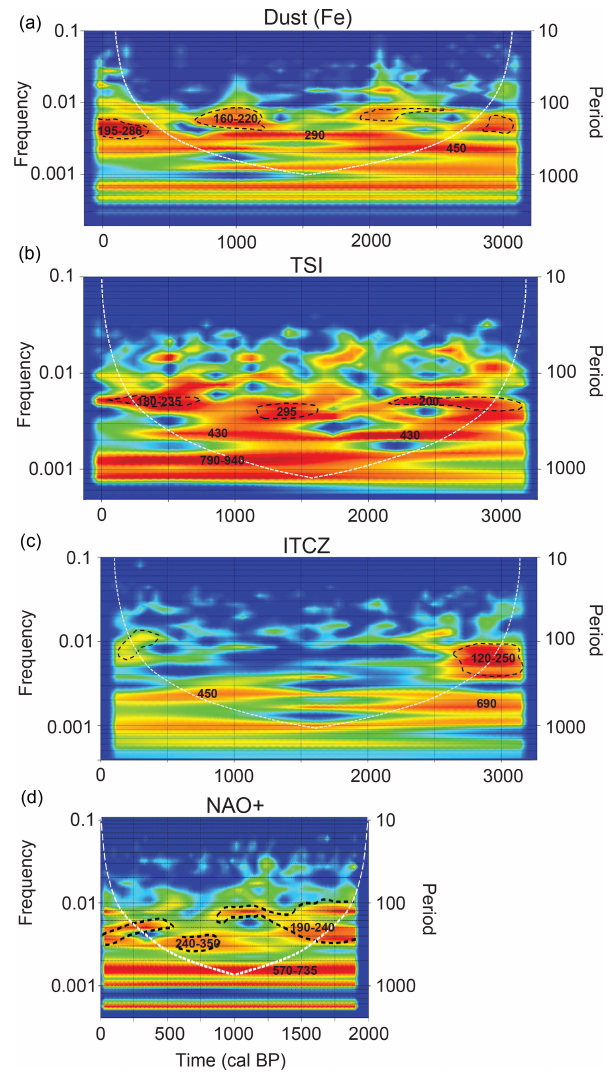
Figure 5. Individual wavelet analyses for (a) dust content (Fe, Lake Bastani), (b) TSI (Steinhilber et al., 2012), (c) ITCZ (Haug et al., 2001), and (d) NAO+ (Franke et al., 2017) signals. The NAO signal covers the last 2000 years. The occurrence of periods (labeled in black) with respect to time is given by the bright yellow–red colors. The 95% confidence levels are indicated with the dotted